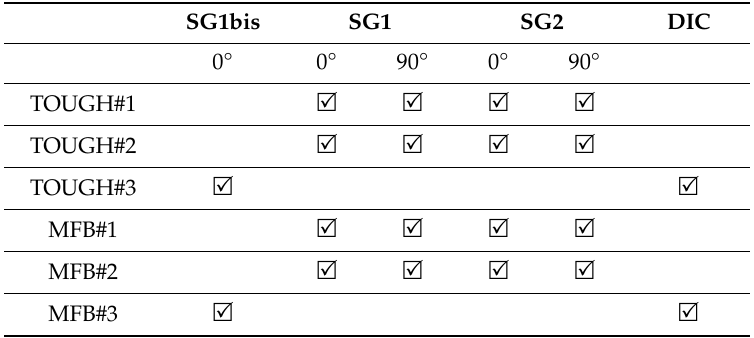
Figure 3. Specimen stacking sequence and delamination position along the thickness. Table 1. Tests matrix.